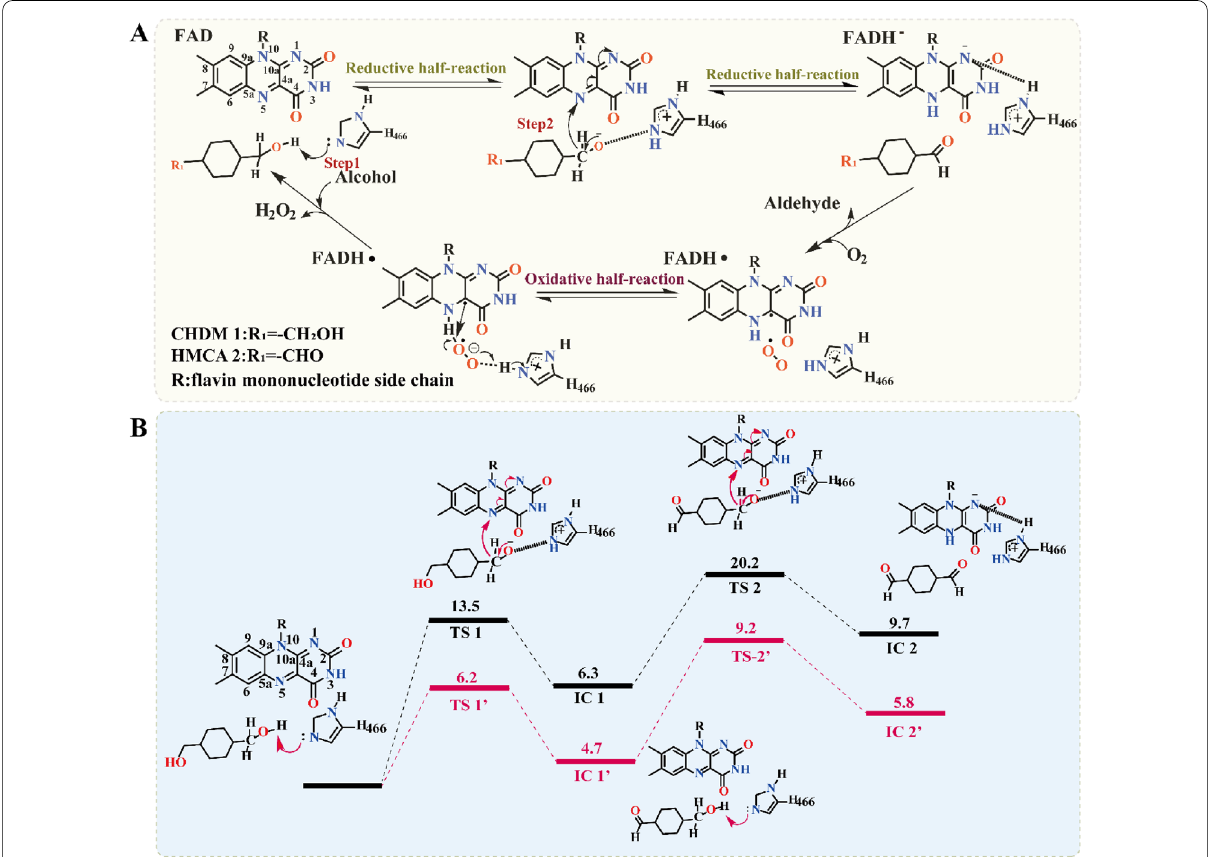
Fig. 3 QM/MM calculation of Ac CO. A Proposed catalytic reactions of Ac CO. The proton and hydride (H − ) transfer from CHDM and HMCA to H466 (N ε2 ) and FAD N(5) is marked as arrows. B Relative energy profile (in kcal mol − 1 ) of hydride (H − ) transfer from CHDM and HMCA, along with · schematic drawings of key intermediates involved in the reaction. The WT is shown in black line, variant W4 is shown in red